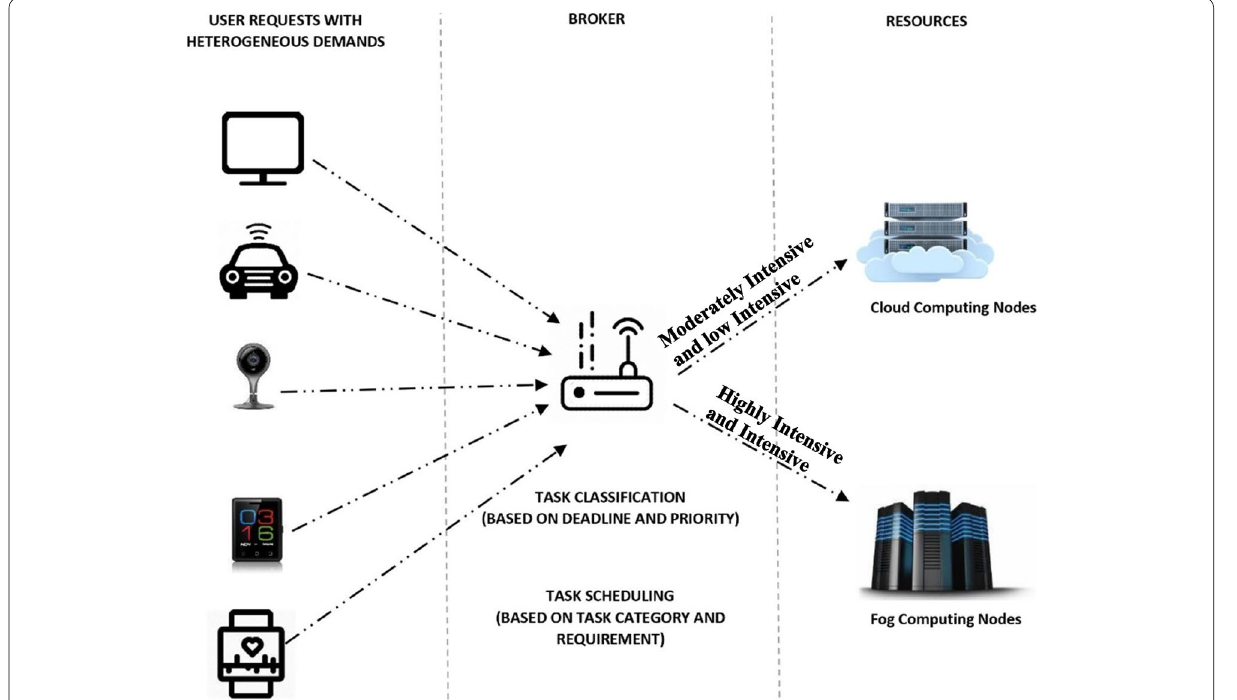
Fig. 2 Fog integrated cloud system